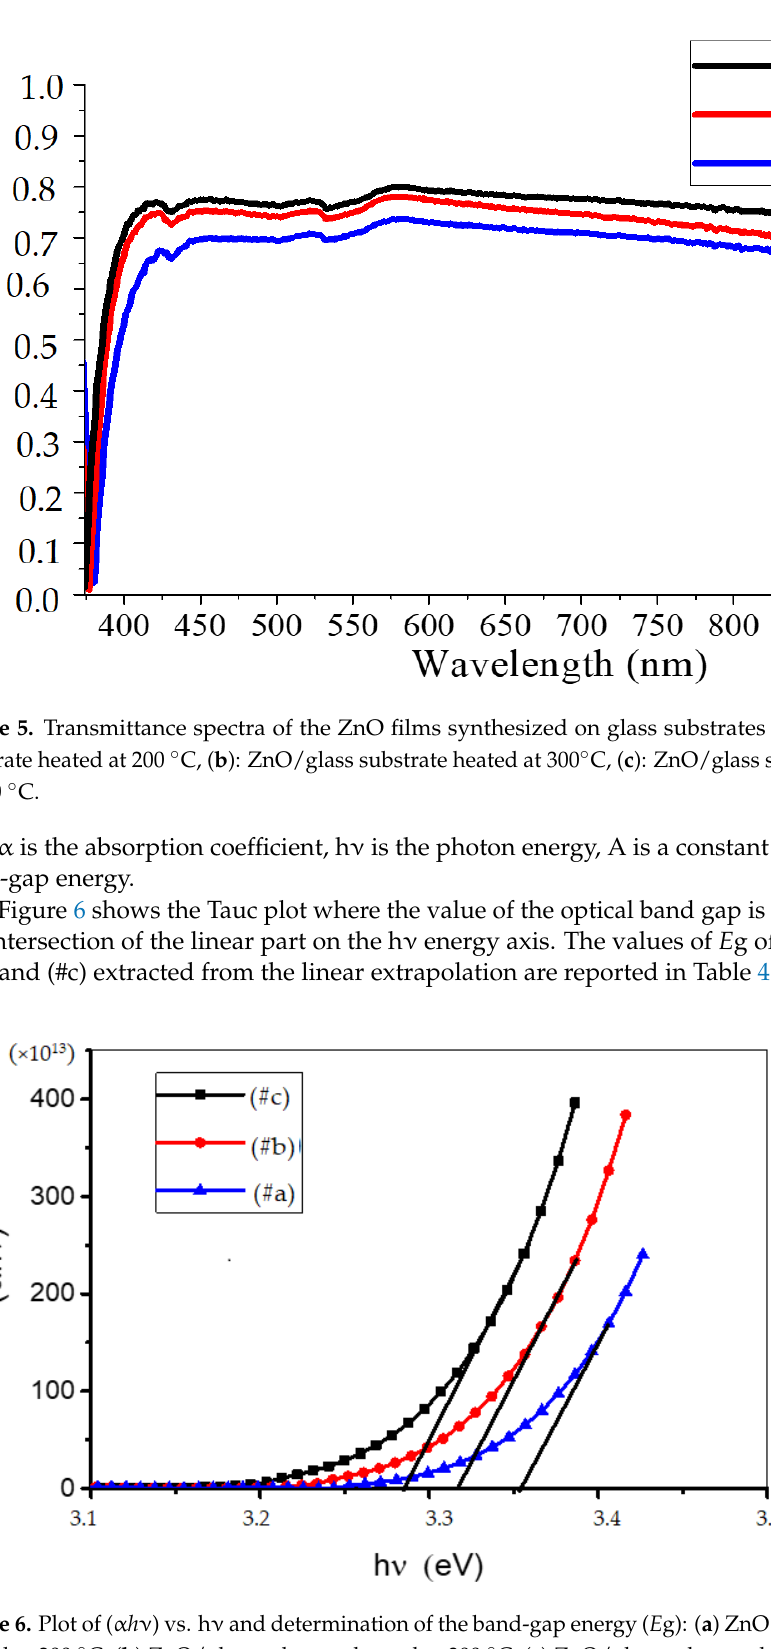
Figure 6. Plot of (α h ν) vs. hν  and determination of the band-gap energy ( E g): ( a ) ZnO/glass sub- Figure 6. Plot of ( α h ν ) vs. h ν and determination of the band-gap energy ( E g): ( a ) ZnO/glass substrate heated at 200 ◦ C, ( b ) ZnO/glass substrate heated at 300 ◦ C, ( c ) ZnO/glass substrate heated at 400 ◦ strate heated at 200 °C, ( b ) ZnO/glass substrate heated at 300 °C, ( c ) ZnO/glass substrate heated at 400 °C.